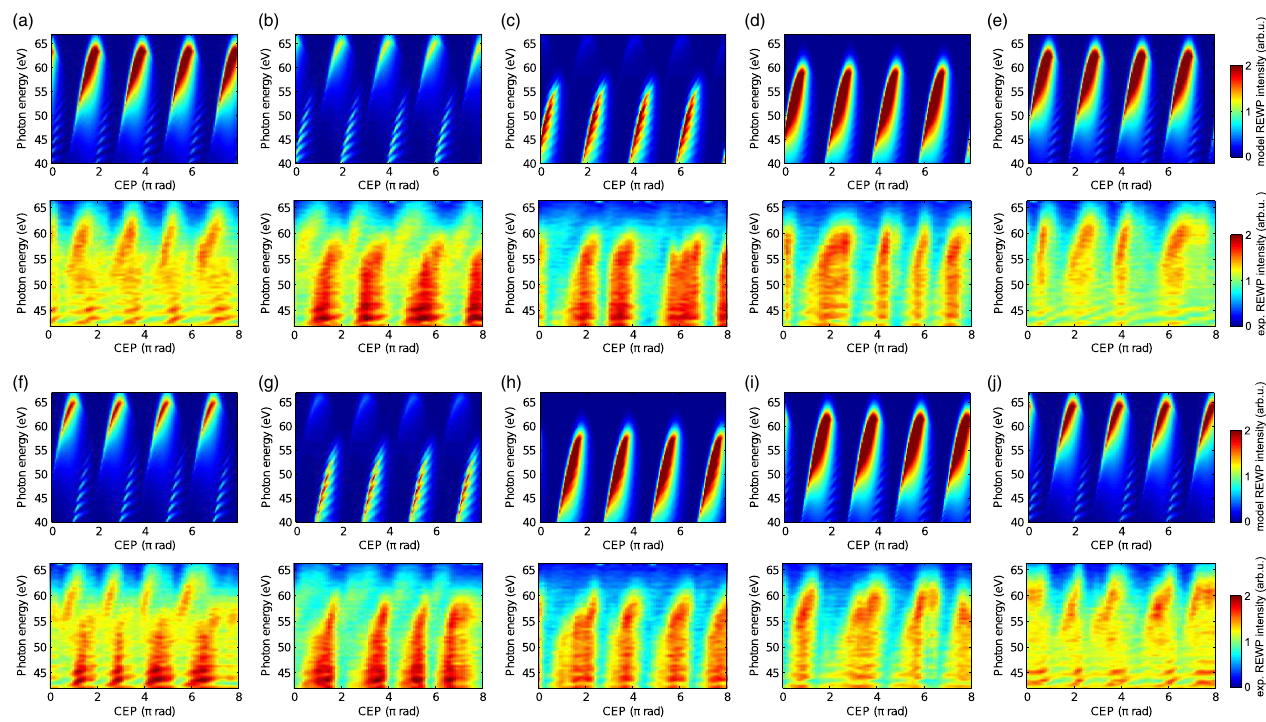
FIG. 4. (a) – (j) Simulated (upper) and measured (lower) REWP spectrograms for ϕ 2 ¼ 1 . 19 π , 1 . 42 π , 1 . 65 π , 1 . 88 π , 0 . 11 π , 0 . 34 π , 0 . 57 π , 0 . 80 π , 1 . 03 π , and 1 . 26 π . The simulations were performed for a single 10.3-fs-long optical cycle using the same intensities of the three color components as estimated for the measurements. Only the short trajectory family has been included [24], since under the most commonly encountered experimental conditions this will be best phase matched in a macroscopic medium. The experimental ϕ values have an unknown offset, which could slip between scans for different ϕ 2 . Note that in the low-ionization conditions of these experiments, ϕ 2 may be considered as jitter-free, whereas ϕ is averaged over ≥ 1 rad [24]. Slow ( ∼ 1 Hz) τ 3 jitter is responsible for CEP deviations from the precise 2 π periodicity with ϕ observed in some measured spectrograms [24]. HHG spectra were measured for CEP π = 10 steps of ϕ averaging each time over 100 CEP